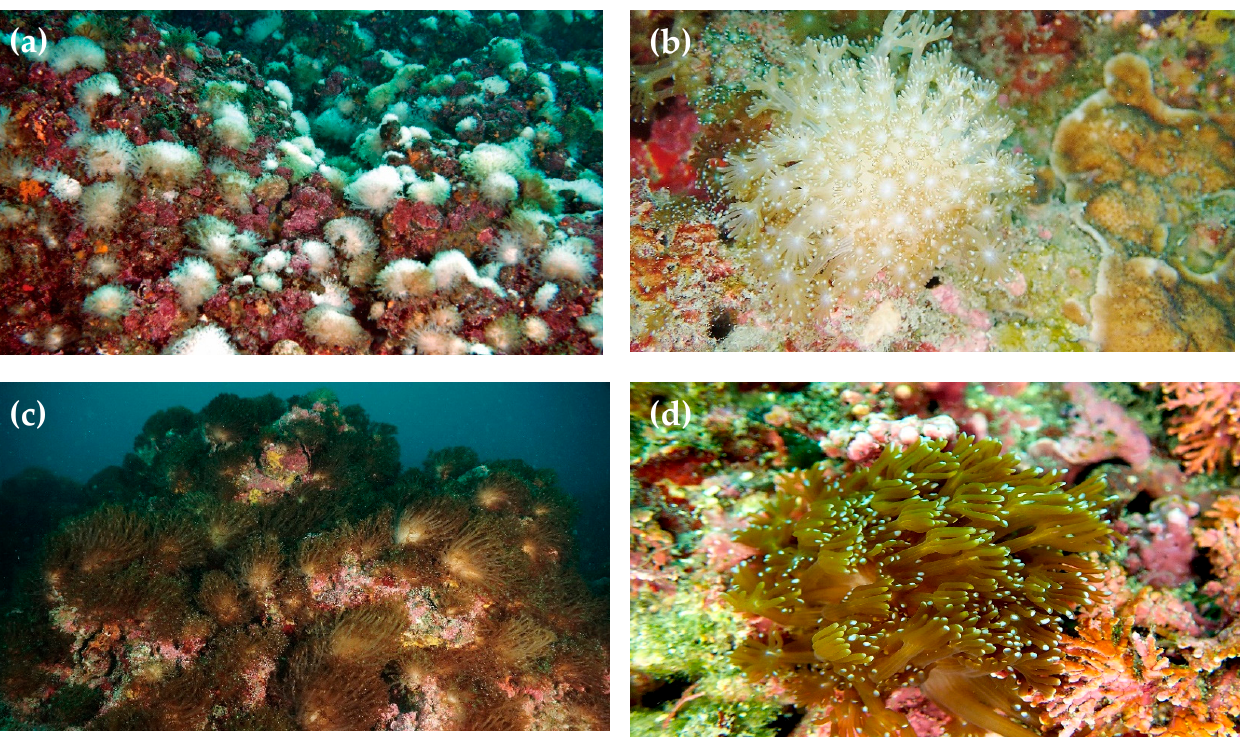
Figure 1. ( a ) Massive bleaching of Alveopora japonica population observed at subtidal of Jeju Island in 2016; ( b ) Bleached Alveopora japonica still actively waving with elongated tentacles; ( c ) Recovered Alveopora japonica population after bleaching event (2017); ( d ) A healthy Aveopora japonica colony in 2017.